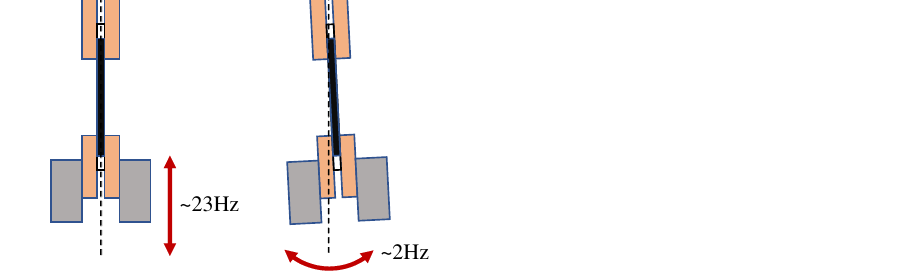
Figure 12. Dominant vertical vibration mode ( left ) and minor pendulum vibration mode ( right ). The identified transfer function is overlaid with red dashed lines. The identified model (dashed red line) and the estimated frequency response (solid blue line) agree very well between 0.03 Hz and 100 Hz. Table 3 shows the constants estimated from the identified transfer functions. The estimated Young’s modulus is in good agreement with that of the datasheet of Elastosil ( E = 0.5 to 2 [MPa]) [46]. Further, the damping time constant τ 1 and the electromechanical coupling ratio β l are also